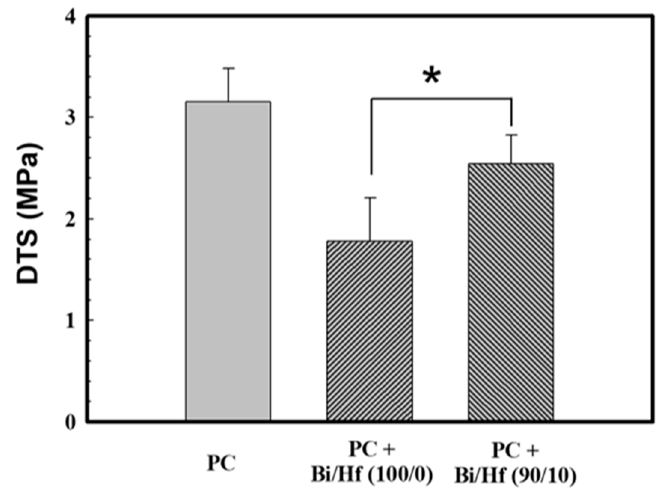
Figure 6. The DTS (diametral tensile strength) of MTA-like cement containing radiopacifier of Bi/Hf (100/0) and (90/10), where Portland cement (PC) is the control group. * indicated that these Table 95. confidence interval.